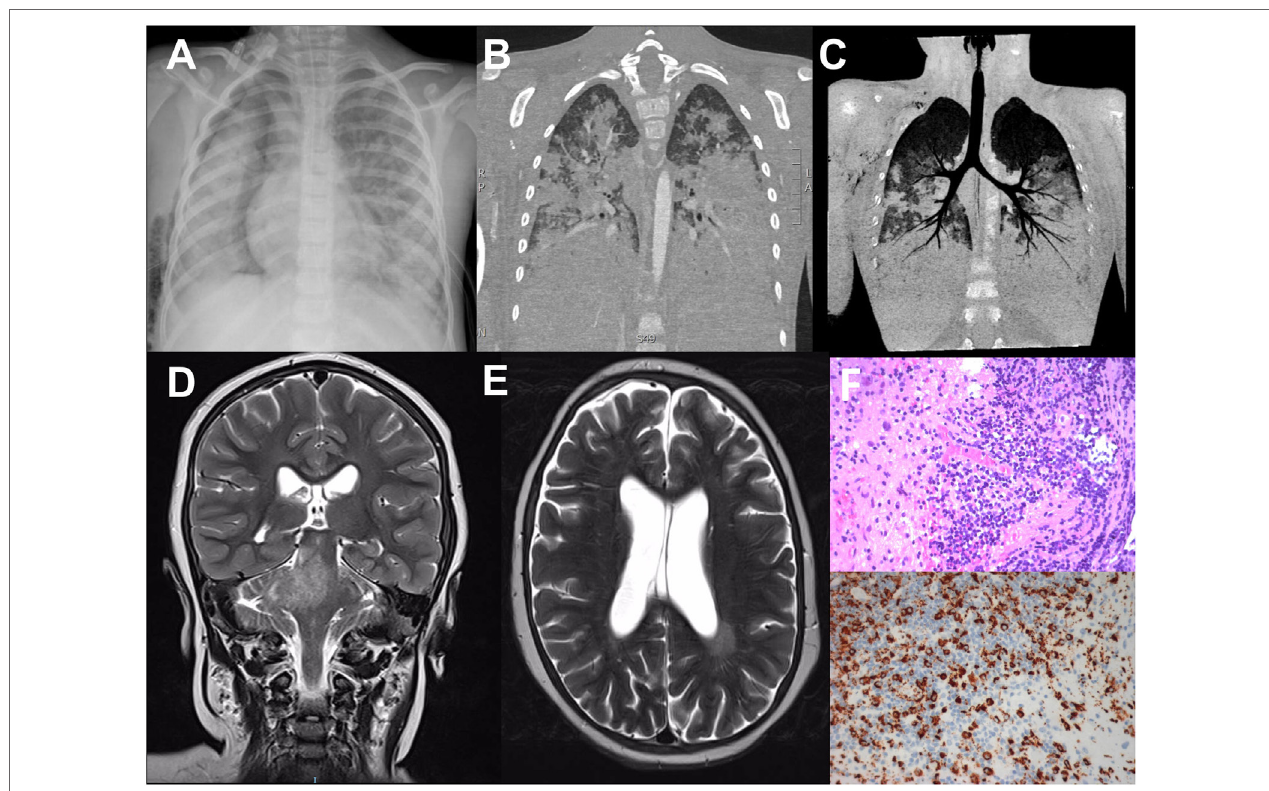
FIgURe 1 | Radiological findings in the dizygotic twins homozygous for 1847A > G (p.Glu616Gly) in UNC13D . (a) Thoracic Rx of the patient 1; broad area of opacity involving the right mediobasal lobe and the left basal lobe, with bilateral hilar and perihilar infiltration. (B,C) Pulmonary CT scan of the patient 1; massive bilateral pulmonary consolidations with alveolar involvement, only sparing the apical lobes. (D,e) Brain MRI scan of the patient 2; T2w image with hyperintense signal in the left periventricular region, in pons, right cerebellar peduncles, and right cerebellar hemisphere. (F) Hematoxylin-eosin staining of the brain biopsy showing lymphohistiocytic perivascular and intraparenchymal inflammatory infiltrate (upper panel); immunohistochemical staining for the histiocytic marker CD68 (lower